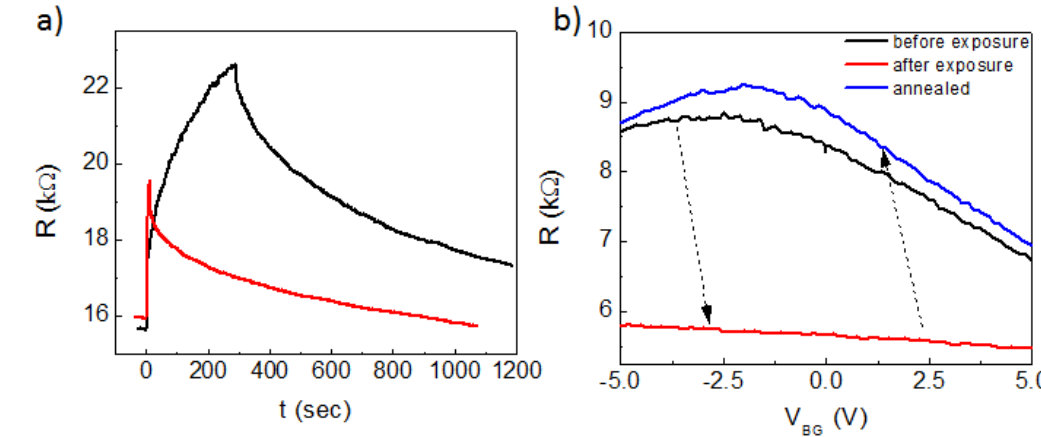
Figure 2. ( a ) Time-evolution of channel resistance during and after non-local exposure. The red curve corresponds to repeated imaging of a 100 x 100 nm window, and the black curve corresponds to a point exposure. The channel resistance in both curves slowly drops back to the pre-exposure values after the beam is blanked. ( b ) Gating curves taken before (black) and after (red) non-local exposure, and after Joule-heating (blue).